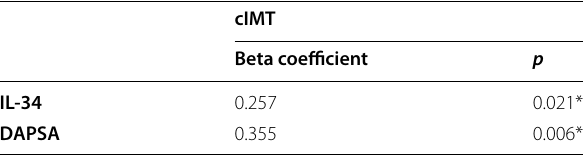
Table 5 Multivariate linear regression analysis for cIMT in PsA patients